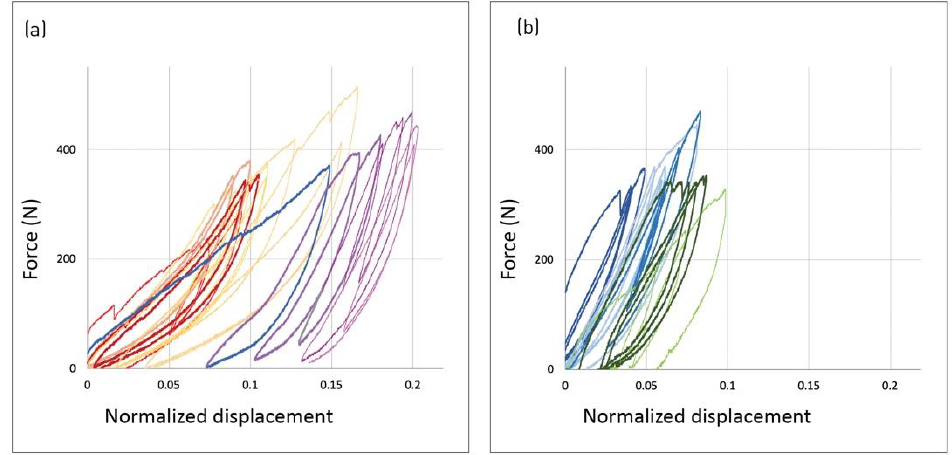
Figure 10. Effect of pleat number—increasing the number of pleats reduces stiffness and increases energy absorption. ( a ) Full pleats: single (purple) and triple (red). ( b ) Simple pleats: single (blue) and triple (green).